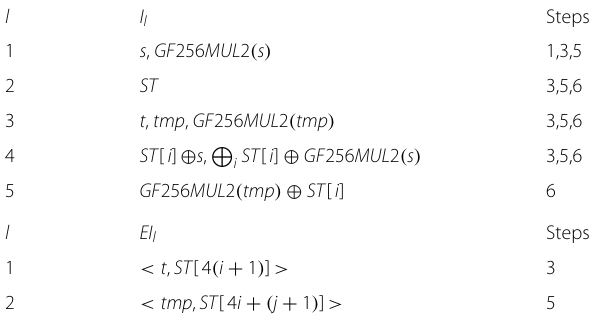
Fig. 6 The process of our proposed first-order masking scheme in one AES round